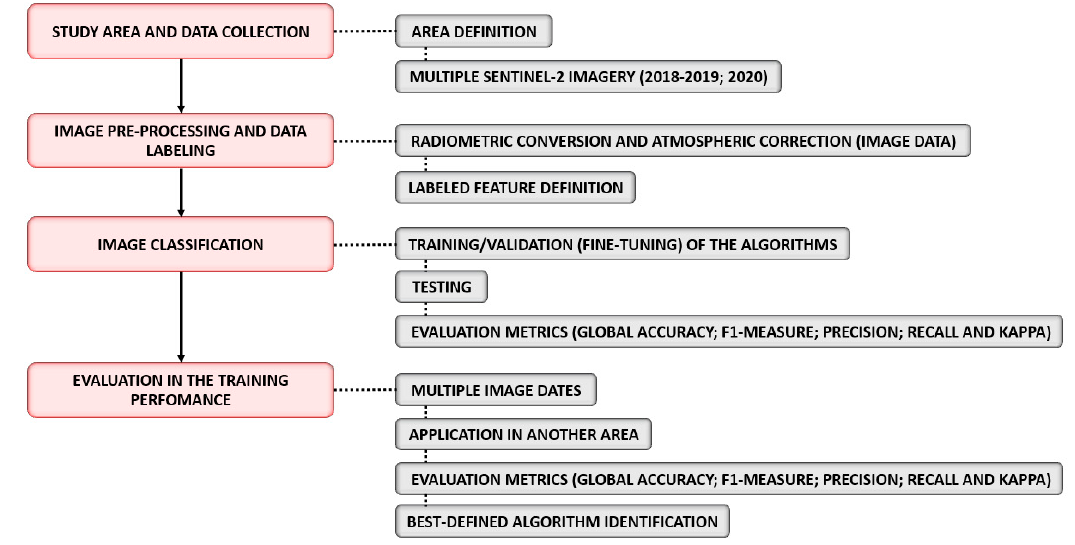
Figure 1. Workflow describing the main stages of the proposed method.